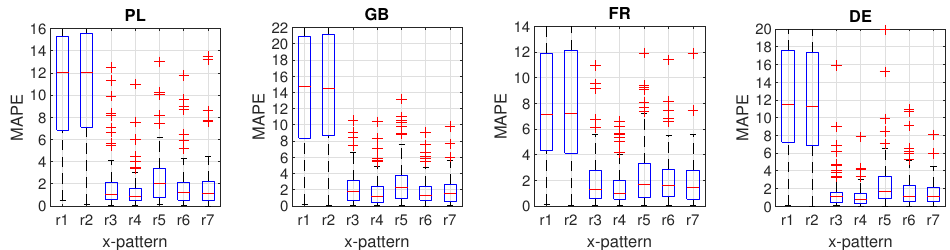
Figure 5. Global training mode: Boxplots of validation MAPE for different input patterns r1–r7.